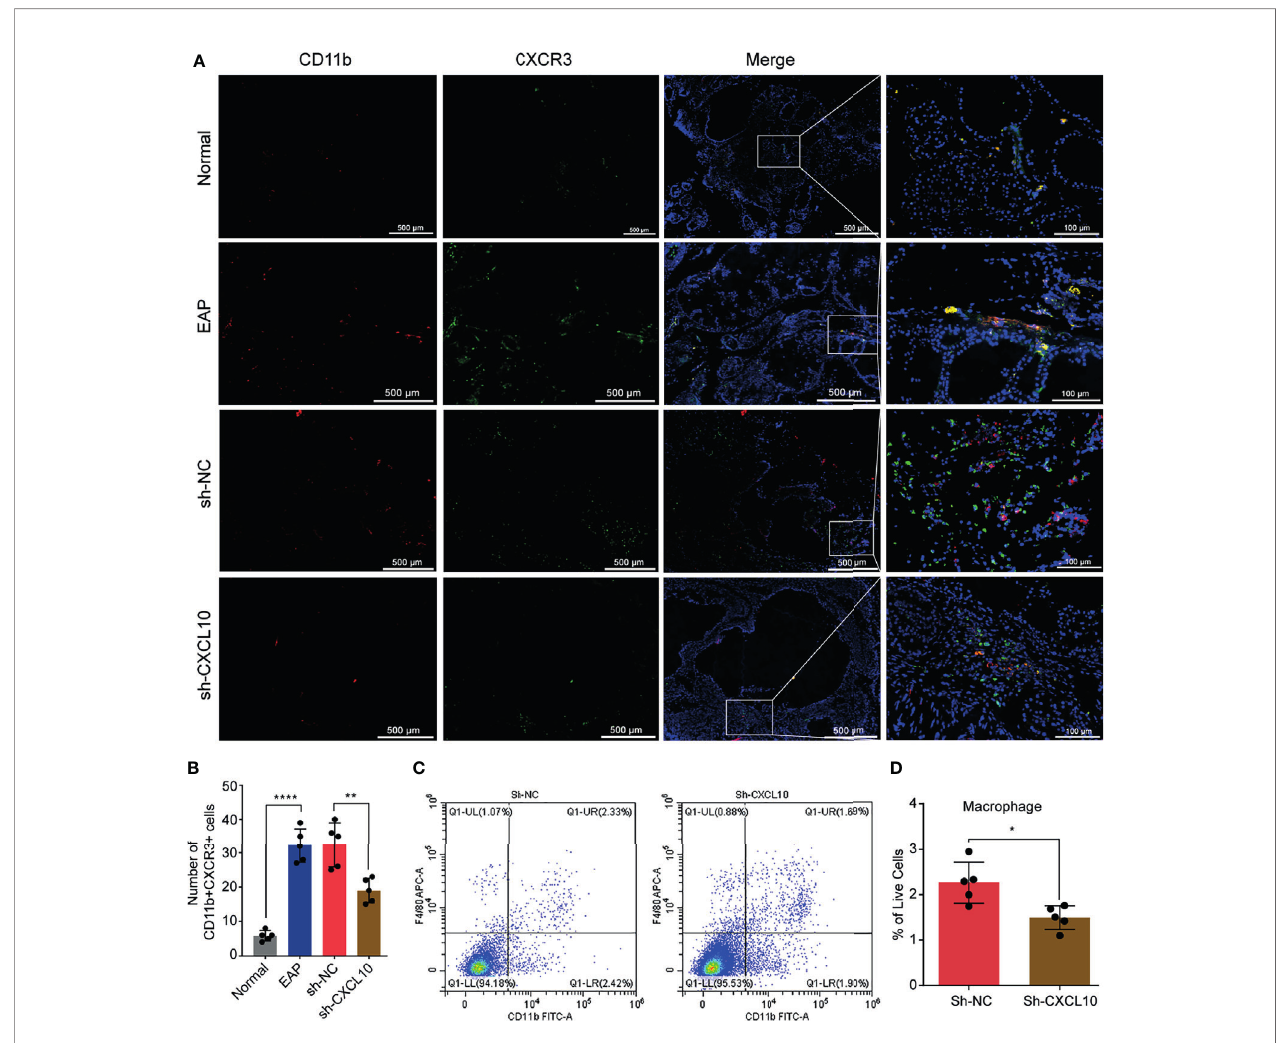
FIGURE 4 | Flow cytometry and immuno fl uorescence analysis for macrophages in the prostate of EAP mice. (A) Representative photographs of immuno fl uorescence staining of CXCR3 and macrophage markers in the prostate of normal, EAP, sh-NC, and sh-CXCL10 mice. Cells were stained for CD11b (red) and CXCR3 (green). (B) The number of CD11b+CXCR3+ cells in the prostate of the normal, EAP, sh-NC, and sh-CXCL10 groups was counted at ×400 magni fi cation. (C, D) The results of fl ow cytometry for macrophages in the prostate of EAP mice. Data are shown as mean ± SD by unpaired, two-tailed Student ’ s t -test analysis. * P < 0.05; ** P < 0.01; **** P <